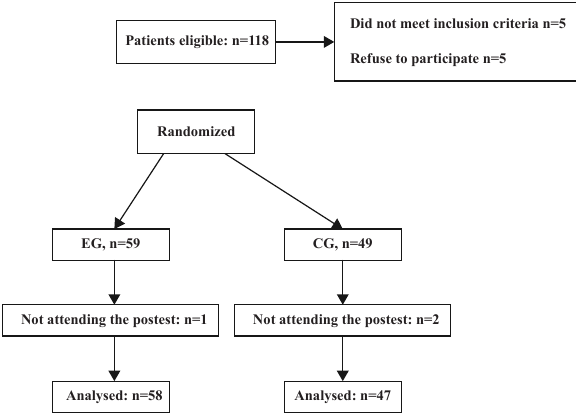
Figure 1. Flowchart progress through the study’s